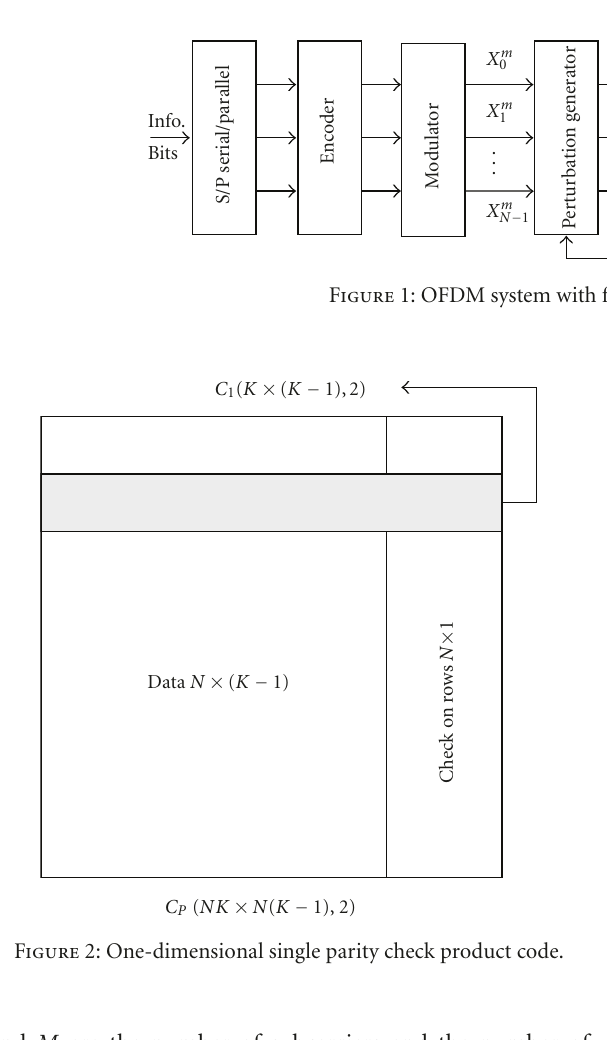
and M are the number of subcarriers and the number of constellation points in the modulation scheme,